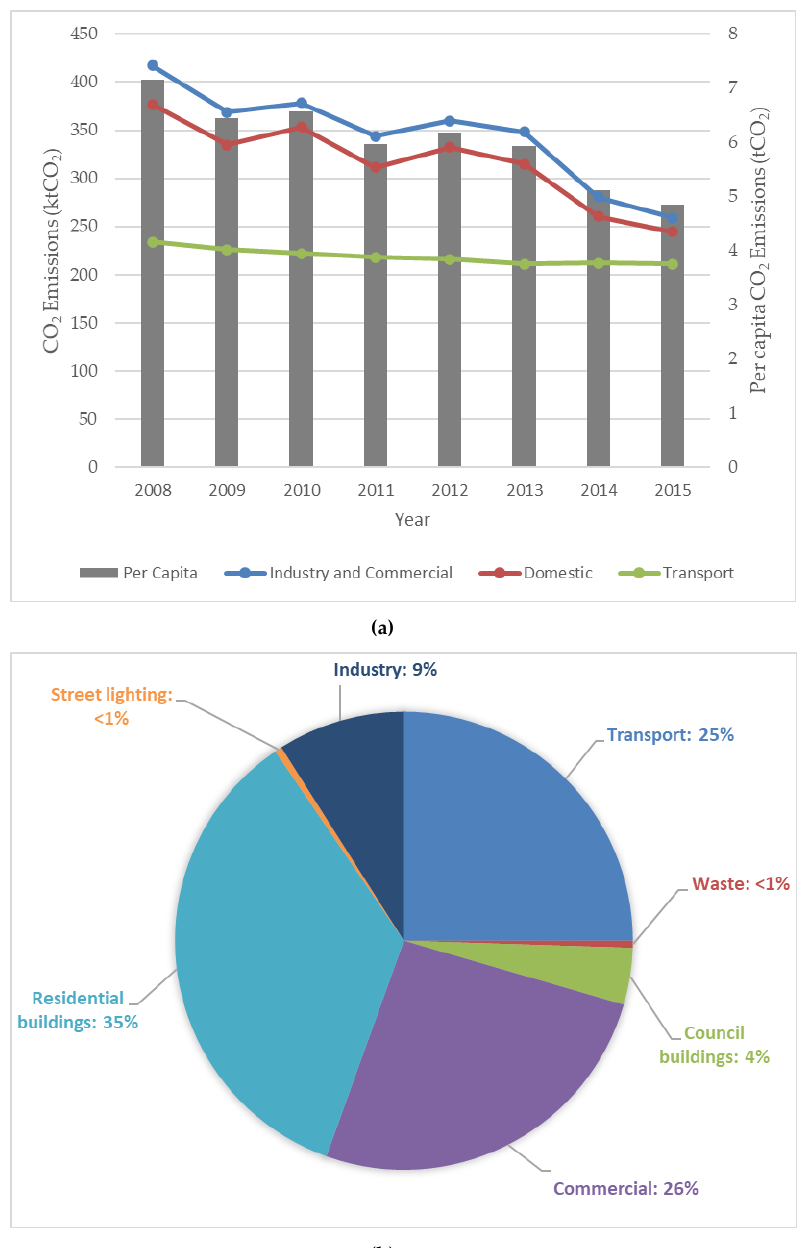
Figure 3. Dundee carbon emissions: ( a ) three main sectors (industry and commercial, domestic and transport) and per capita (2008–2015) and ( b ) all sectors (2015) (sources: based on data from the Dundee Climate Action Plan [24] and data published by Sustainable Scotland Network https://sustainablescotlandnetwork.org/reports/dundee-city-council (accessed: 25 September 2020)).